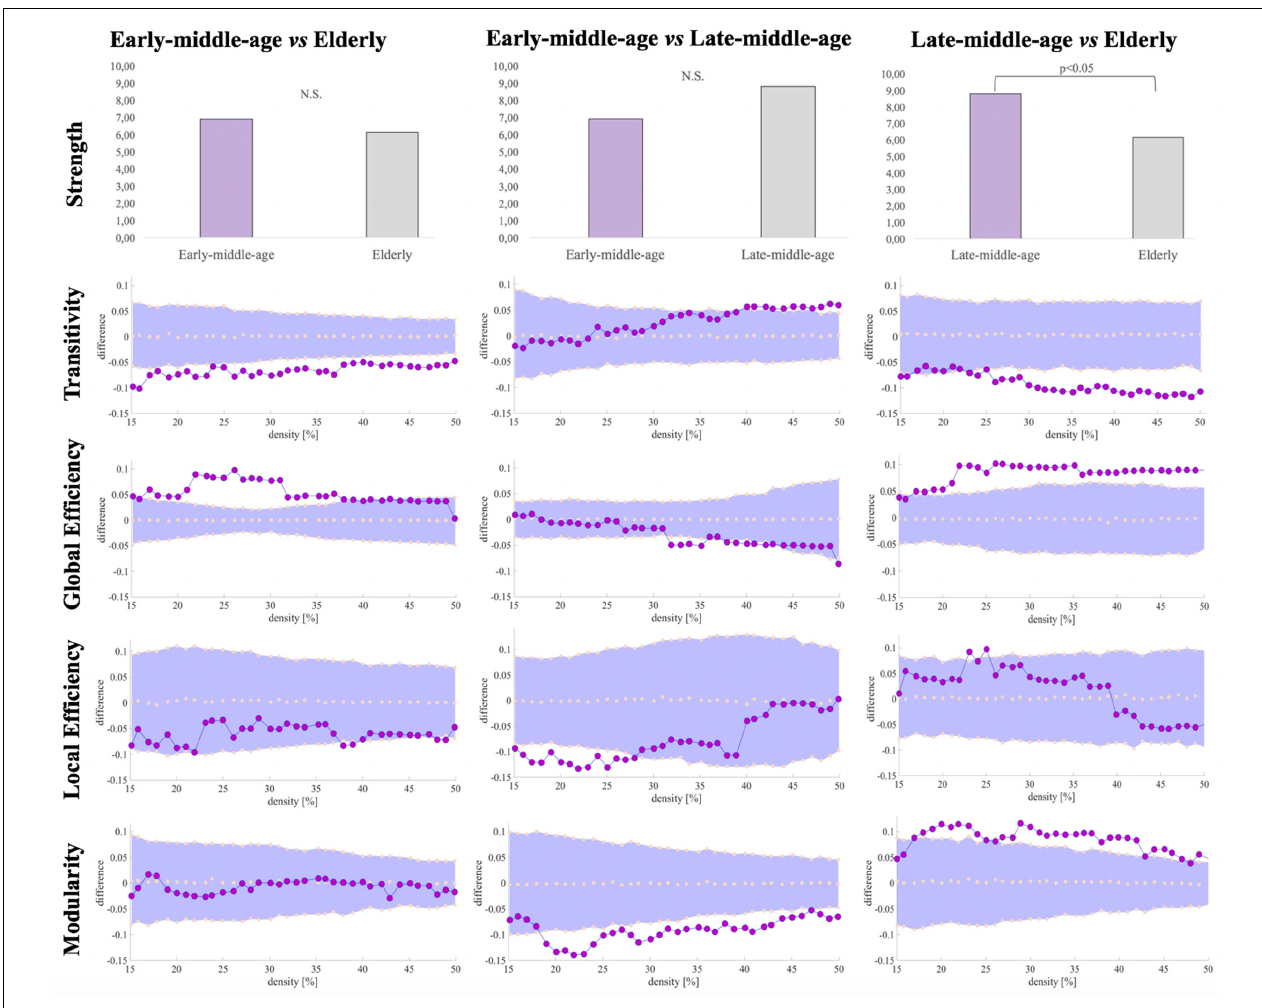
FIGURE 7 | Global network differences in the cognitive connectome across age groups. Figures illustrating modularity, local efficiency, global efficiency and transitivity measures display network densities on the x-axis, spanning from min = 15% to max = 50%, in steps of 1%. Between-group differences in network measures are displayed on the y-axis. Between-group differences are significant when the red circles fall out of the purple-shaded area. N.S., non-significant ( P >